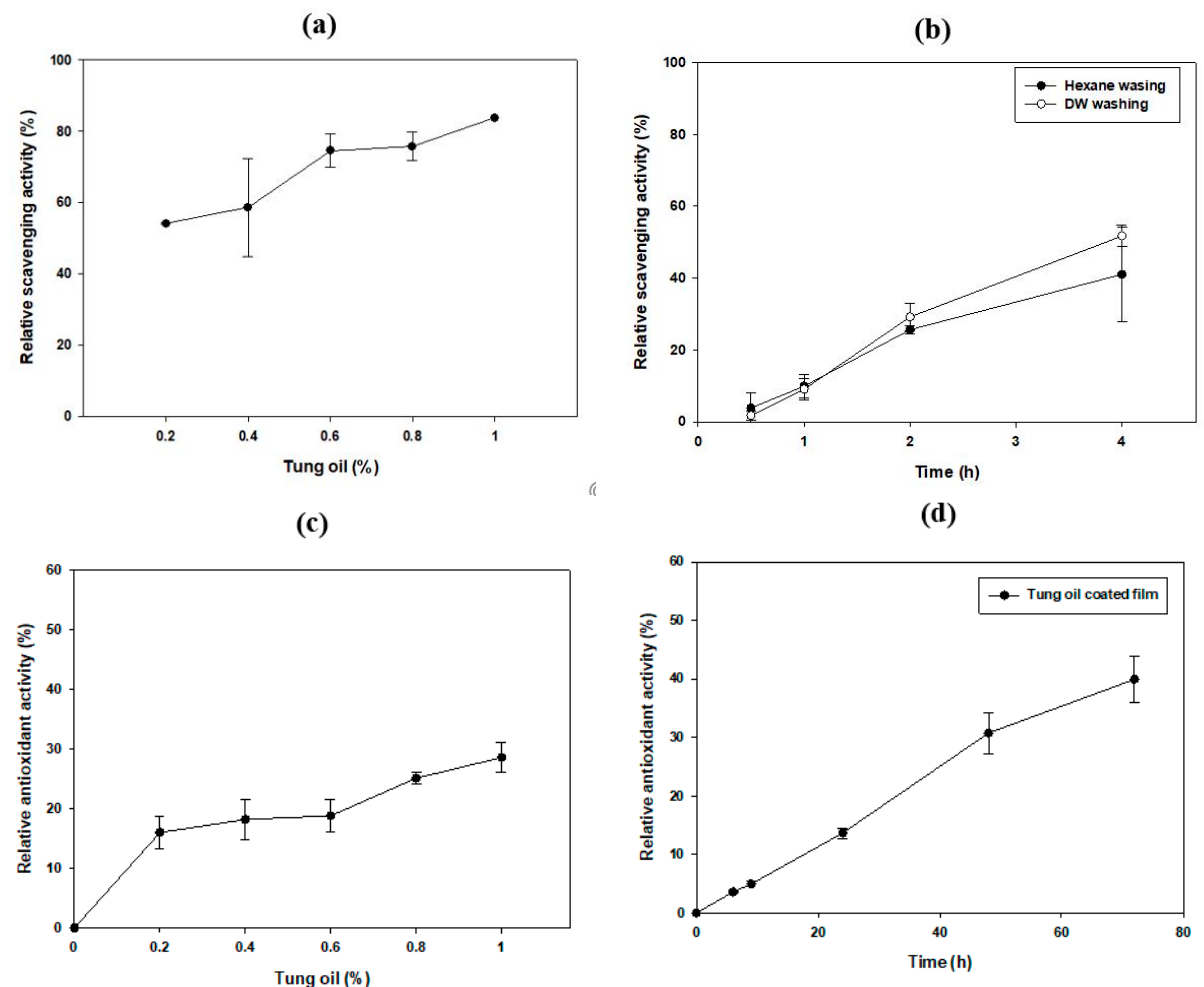
Figure 5. Relative DPPH radical scavenging activity of ( a ) tung oil and ( b ) tung oil-coated films and relative antioxidant activity of ( c ) tung oil and ( d ) tung oil-coated films analyzed by phophomolybdenum assay. Statistical analysis was performed by applying ANOVA with the level of significance at 5%. DW, deionized water. Table 2. Molecular weights and polydispersities of PHA